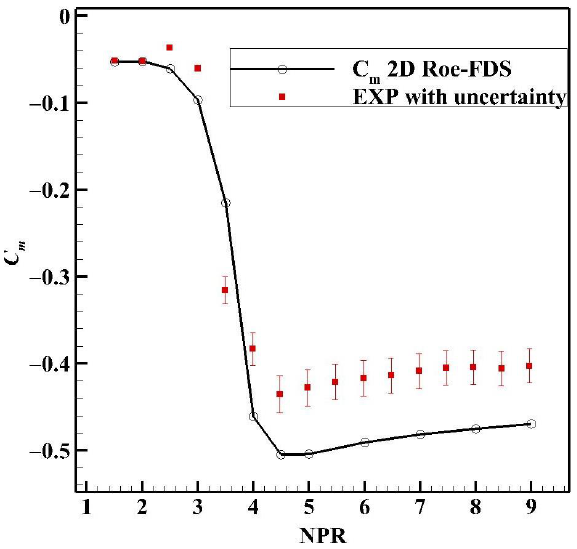
Figure 10. Comparisons of the coefficient of pitching moment at various NPR